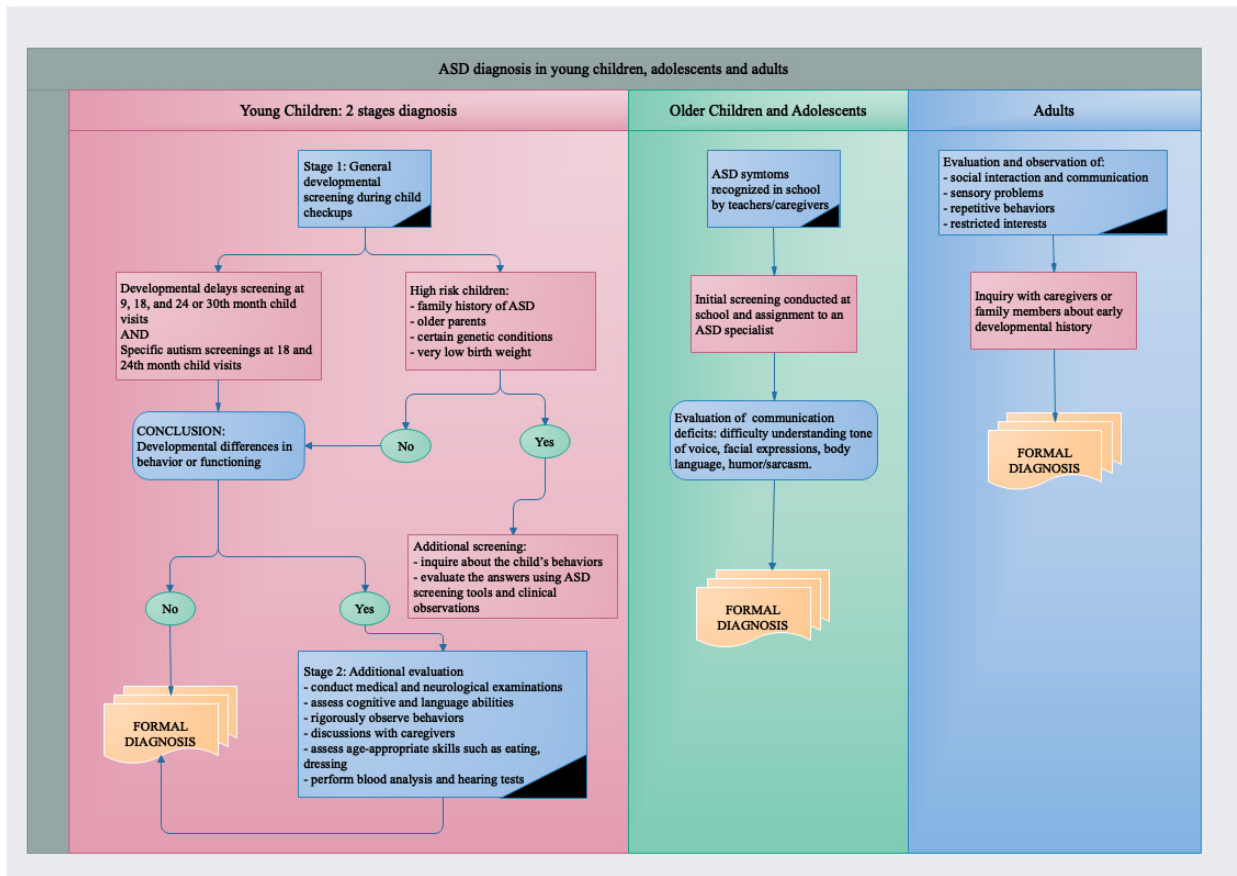
Figure 2. ASD diagnosis. In young children, diagnosis is conducted at 2 different stages (general developmental screening and additional evaluation). However, in adolescents and adults, diagnosis is more difficult, and symptoms are identified following performance in school or social behaviours.